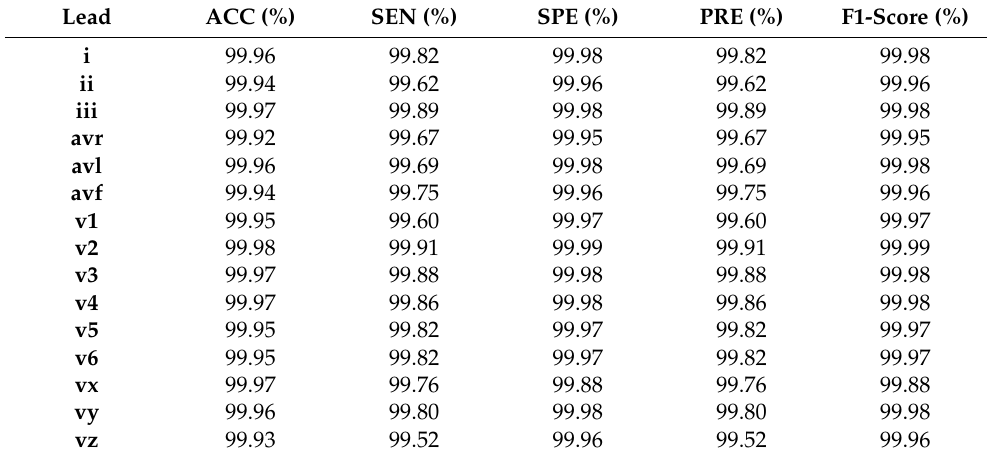
Table 4. Performance result (%) 15 lead ECG.